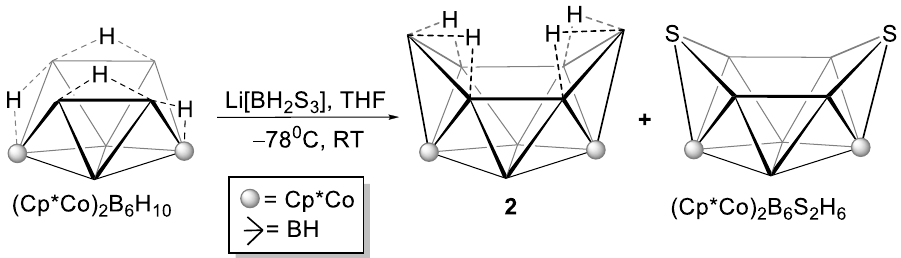
Figure 4. Frontier molecular orbitals of 1’ . Contour value: ±0.05 [e/bohr 3 ] 1/2